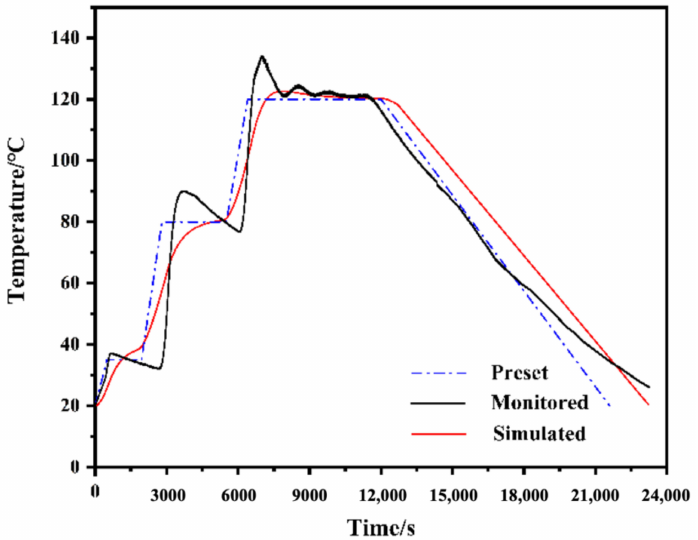
Figure 6. Comparison between preset, monitored and simulated temperature